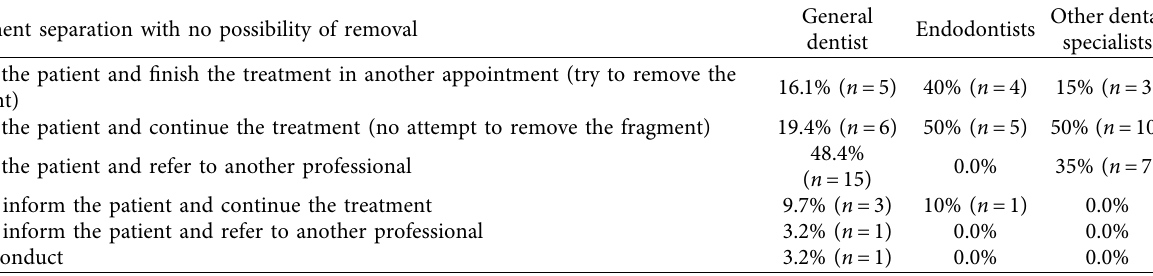
Table 5: Frequency of respondents when related to their conduct in case of instrument separation with the possibility of fragment removal ( p ≥ 0.25).